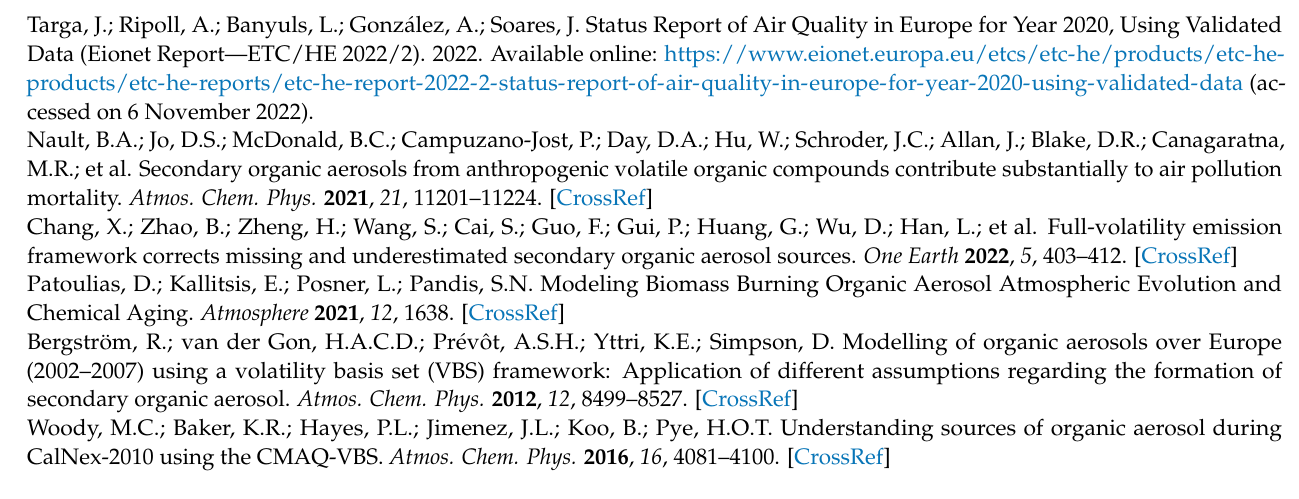
profile; Figure S22: Organic aerosol, San Pietro Capofiume site; Figure S23: Volatility distribution data; Table S1: Values of the performance indicators for NOx, O 3 , SO 2 , PM 10 , and PM 2.5 over the Po Valley domain; Tables S2–S4: Values of the performance indicators for the four simulations at Ispra, Bologna and San Pietro Capofiume site; List of Statistical indicators for model performance